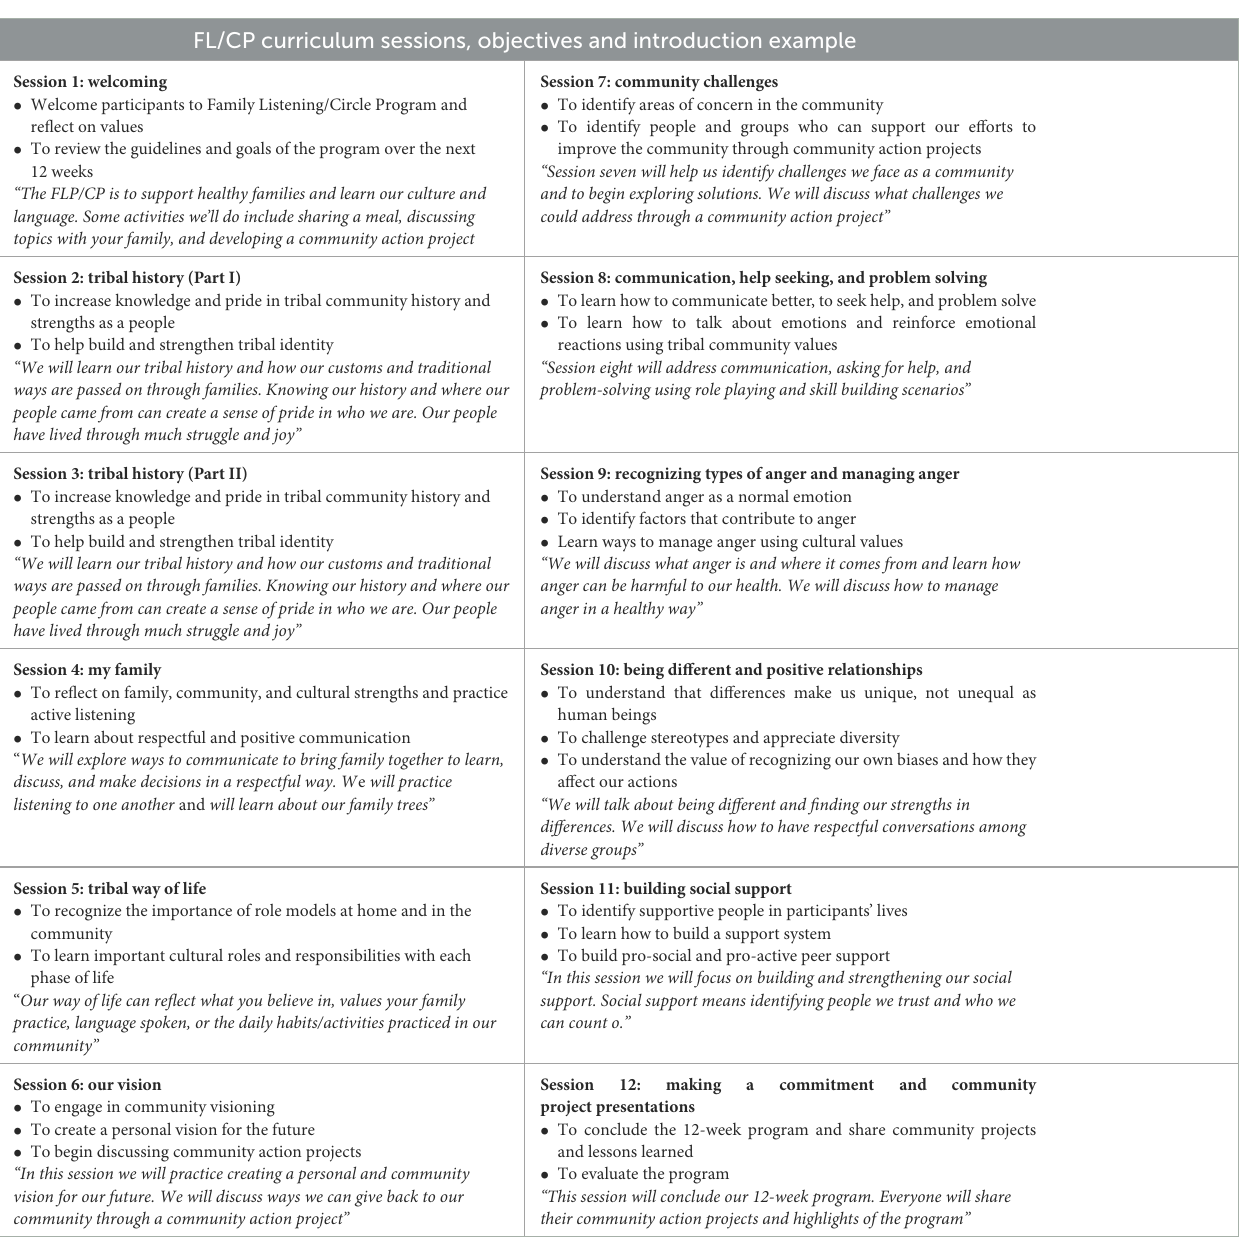
TABLE 1 Family listening/circle program